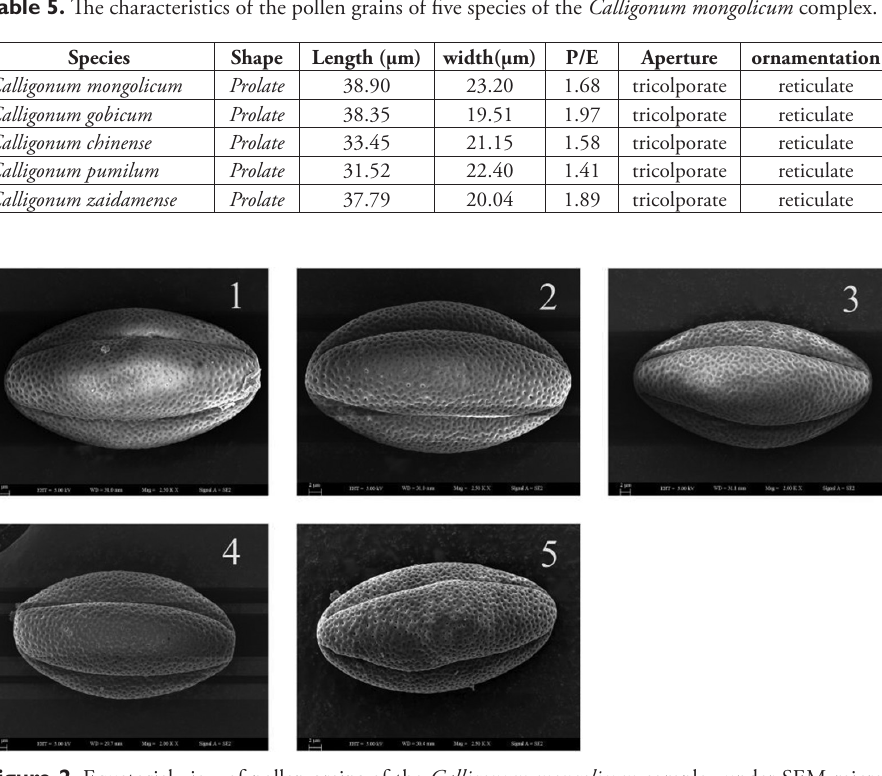
Figure 2. Equatorial view of pollen grains of the Calligonum mongolicum complex under SEM micro- graphs. 1 C. mongolicum 2 C. chinense 3 C. gobicum 4 C. pumilum and 5. C.